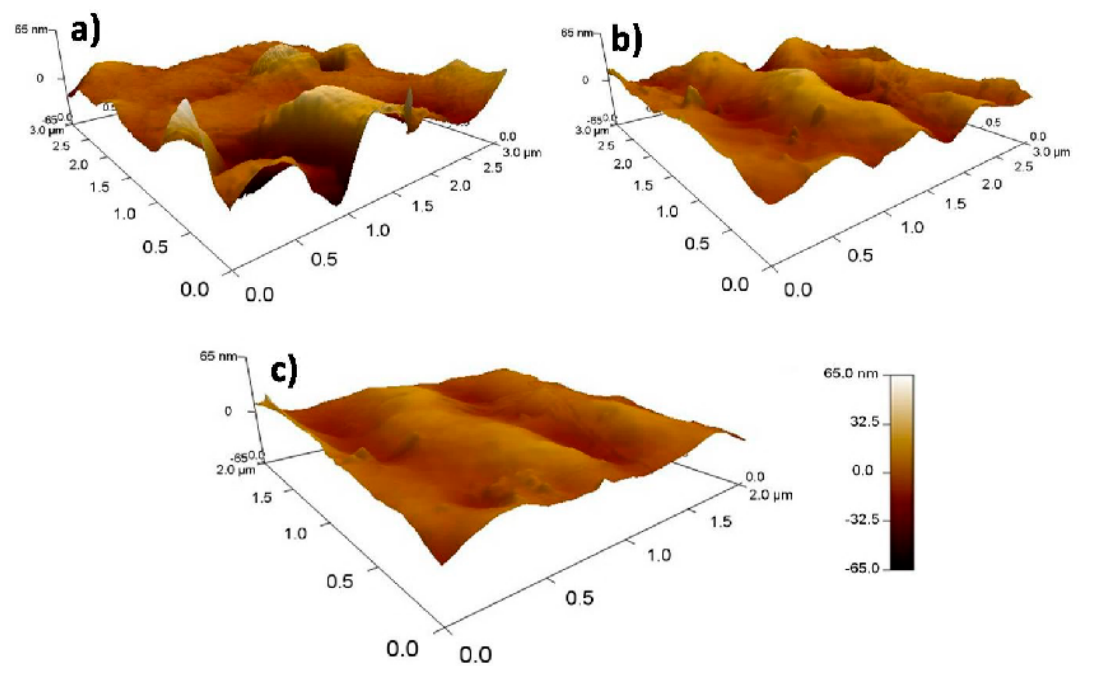
Figure 3. AFM images of ( a ) SWPS, ( b ) SWPS/MNp (10 wt%) and ( c ) SWPS/MNp (20 wt%).